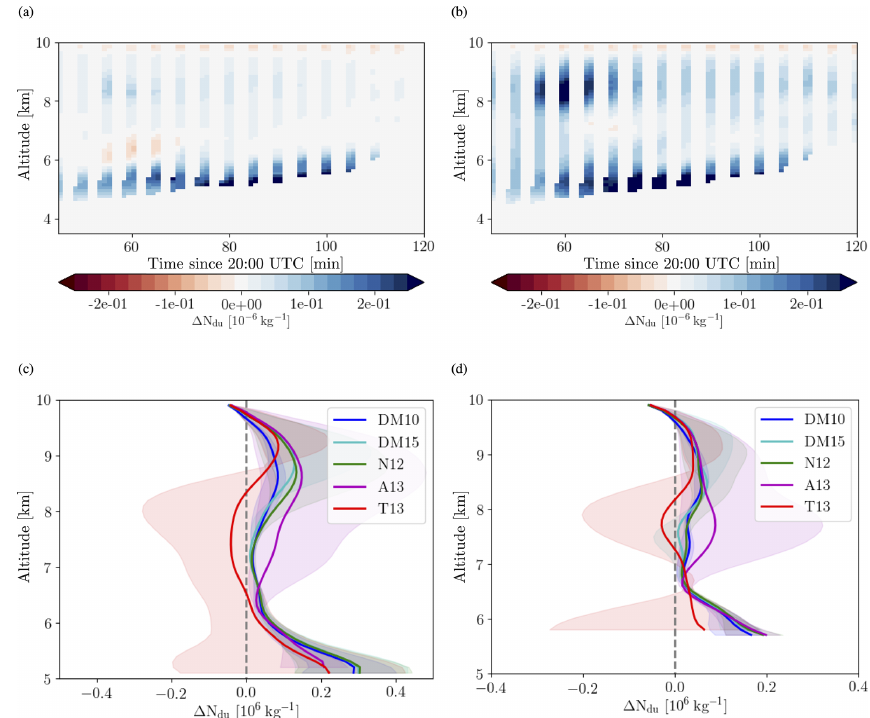
Figure 8. As Fig. 7 but showing the change in dust number concentration.